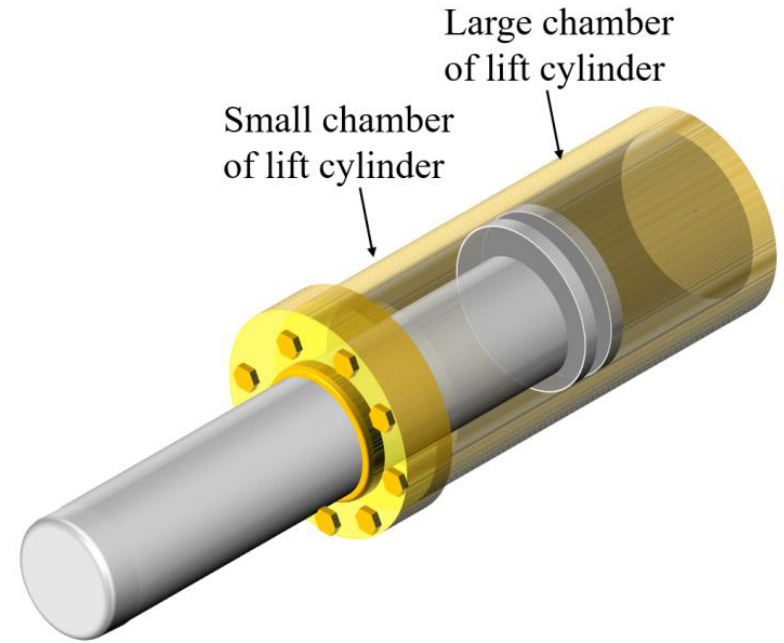
Figure 12. Sensors. Figure 12.